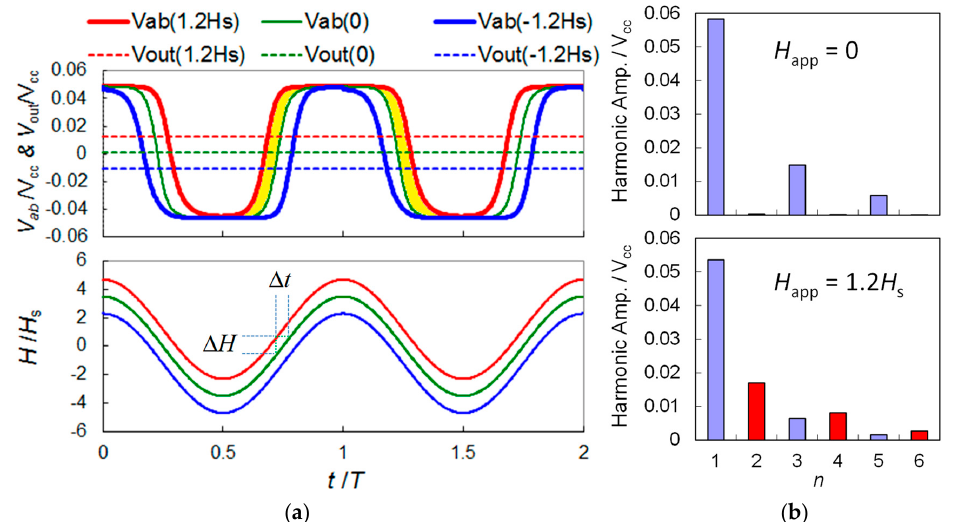
Figure 3. Analytic model for the modulated output of a GMR spin-valve bridge sensor: ( a ) Time trace of voltage output ( V ab ) and DC level ( V out ). The excitation waveform is also shown at the bottom for comparison, where t is the time and T denotes the cycle time. ( b ) Harmonic spectrum of V ab with and without an applied field.